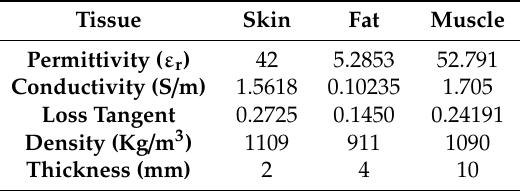
Table 2. Specification of human body tissues.